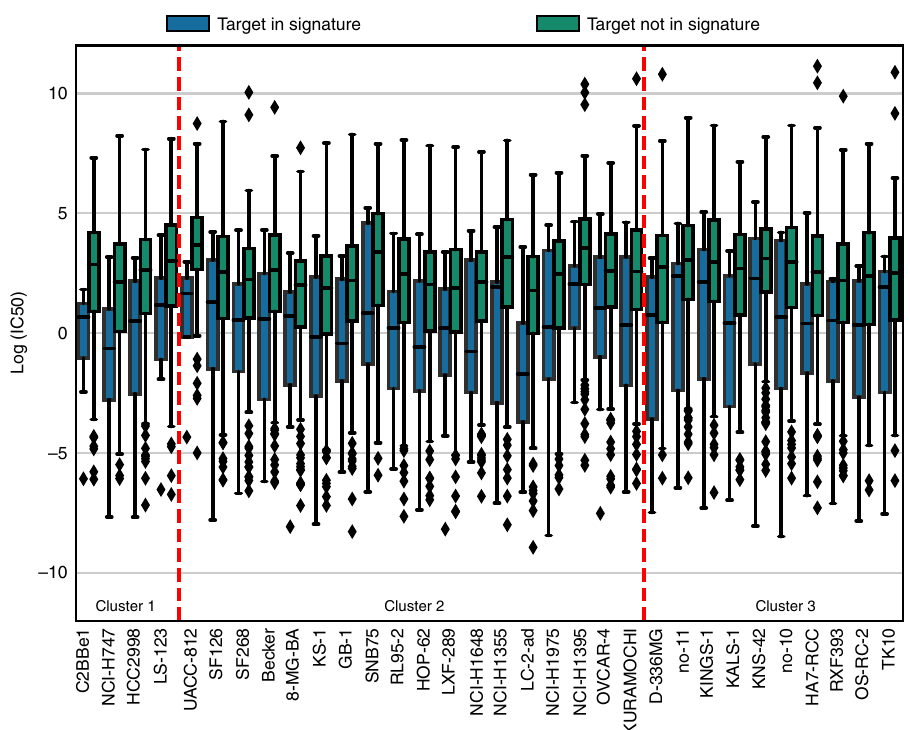
Fig. 6 Sensitivity to drugs targeting signature genes. We retrieved drug screening data from the GDSC project and considered the cell lines associated to the tumours in our clusters. The signi fi cance was evaluated with Student ’ s t test (two-sided p -value < 0.05). The continuous horizontal line is the median, the lower and upper boundary represents the 25th and 75th percentiles, respectively. Whiskers extend to data points that lie within 1.5 interquartile ranges of the lower and upper quartiles; and observations that fall outside this range are displayed independently. Blue boxplots: IC50 values for signature genes; green boxplots: IC50 values for all other genes in GDSC targeting the same cell